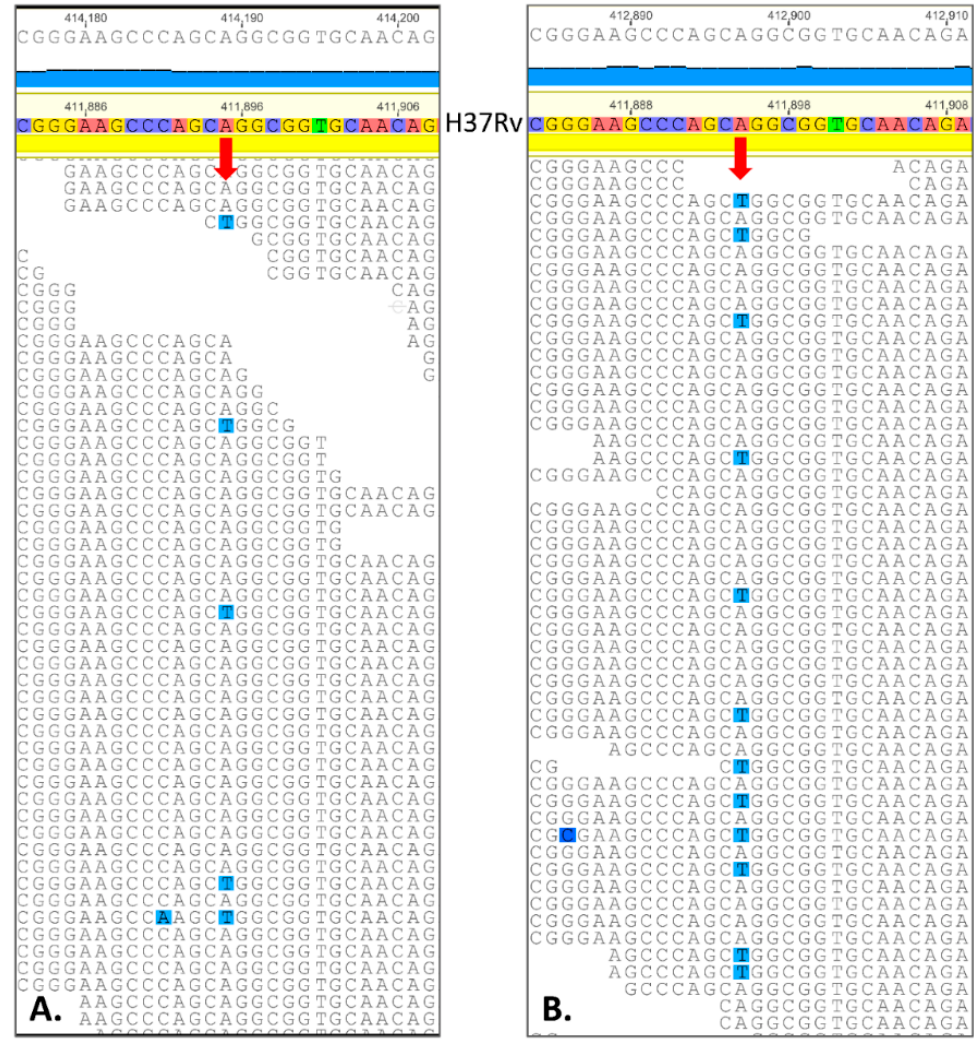
Figure 1. Example of mutant position (genome position 411,895 A > T, iniA gene) with mixed wild type and mutant (highlighted by blue) alleles, with increasing percent of mutant alleles in M. tuberculosis H37Rv subcultures grown under higher (2 × and 8 × MIC) concentrations of compound 11 —1.0 µ M ( A ) and 4.0 μ M ( B ). Only part of the reads is shown that fit the Geneious window. The reads were aligned to the reference genome H37Rv (NC_000962.3). The red arrow indicates the position.